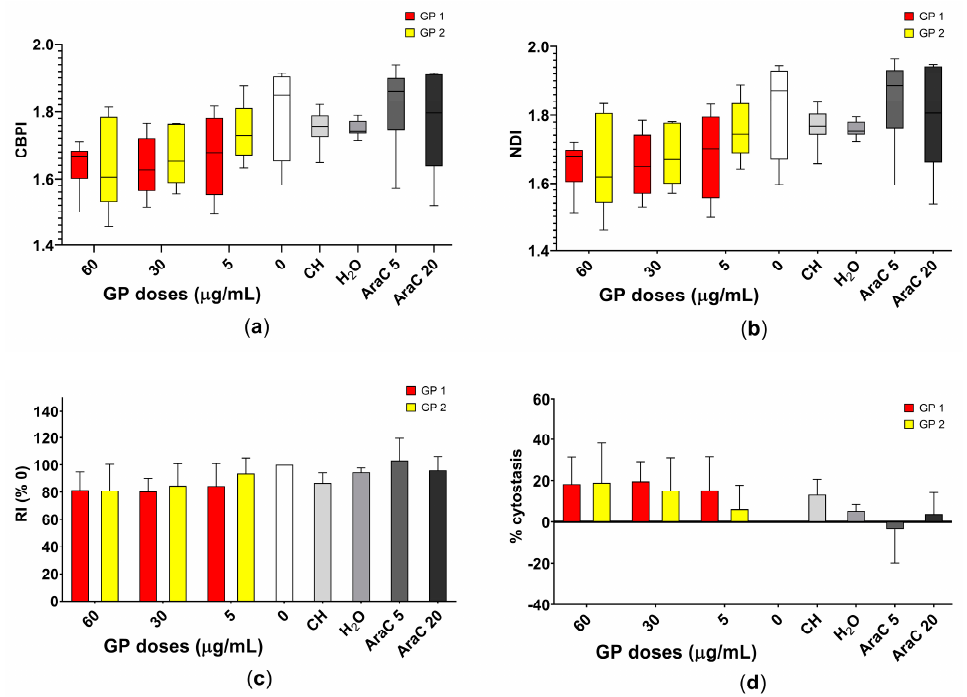
Figure 4. Assessment of the cell proliferation of THP-1 cells after 40 h of exposure to two types of graphene platelets (GP1, GP2) in a concentration of 0–60 µ g/mL by CBMN. Assessment of the ( a ) cytokinesis-block proliferation index ( CBPI ); ( b ) nuclear division index ( NDI ); ( c ) replication index ( RI ) and ( d ) approximation of the percentage of cytostasis. Data are presented in a boxplot with a median with interquartile range or as mean ± standard deviation. CH—sodium cholate (in a concentration corresponding to 60 µ g/mL); H 2 O—water (in a concentration corresponding to 60 µ g/mL); AraC 5 or 20—cytosine arabinoside (in concentrations of 5 and 20 ng/mL).